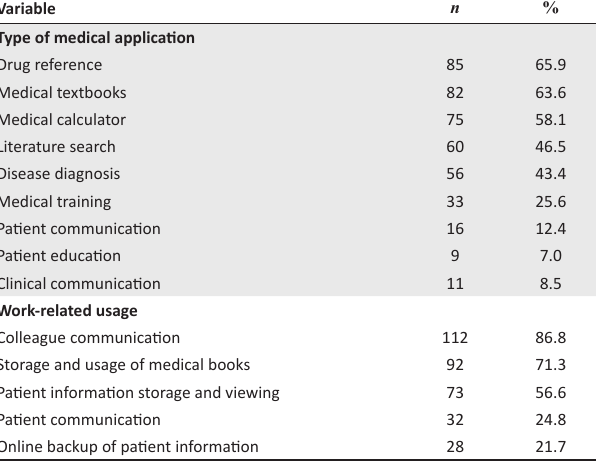
Clinical communication Work-related usage